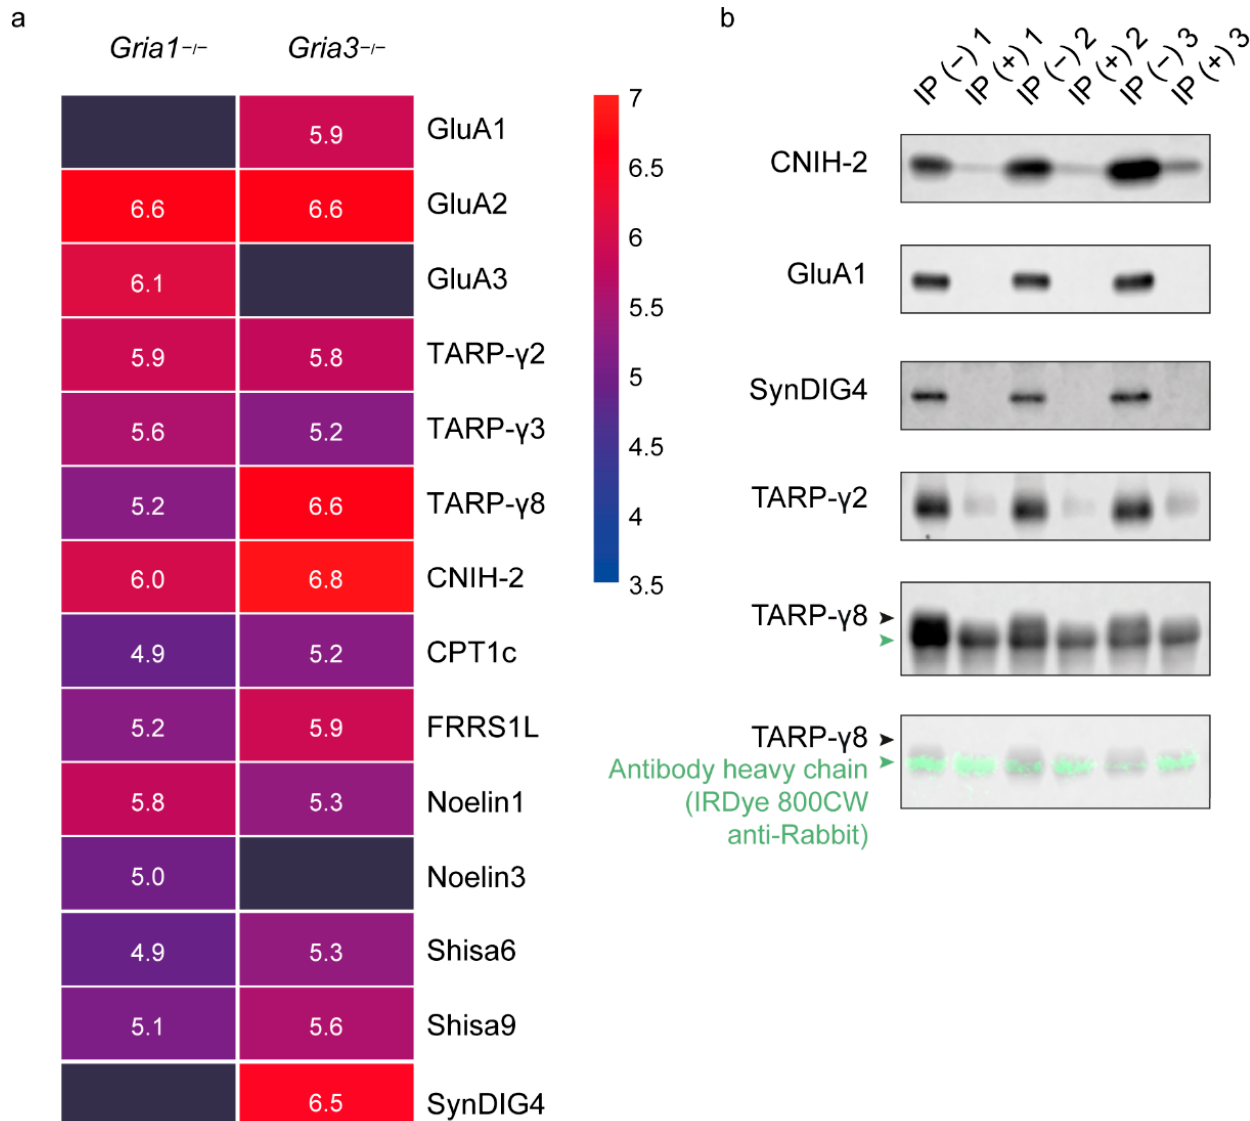
CNIH-3, TARP- γ 8, TARP- γ 2 and Rap-2b (Figure 3a), demonstrating the presence of a TARP- γ 8-SynDIG4 assembly by both approaches.